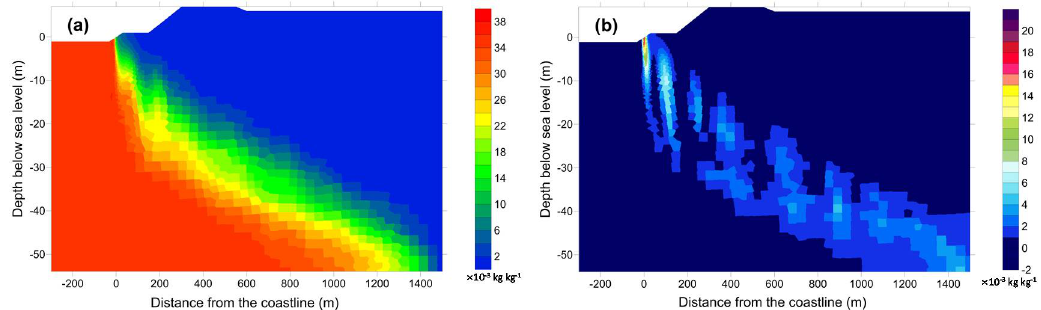
Figure 6. ( a ) Salinity for the baseline and ( b ) salinity differences between the baseline and the scenario 2090RCP45_RR2090RCP45 (0.57 m SLR with a freshwater recharge rate of 0.0058 kg s −1 ) in × 10 −3 (kg-dissolved solids) (kg-seawater) −1 .